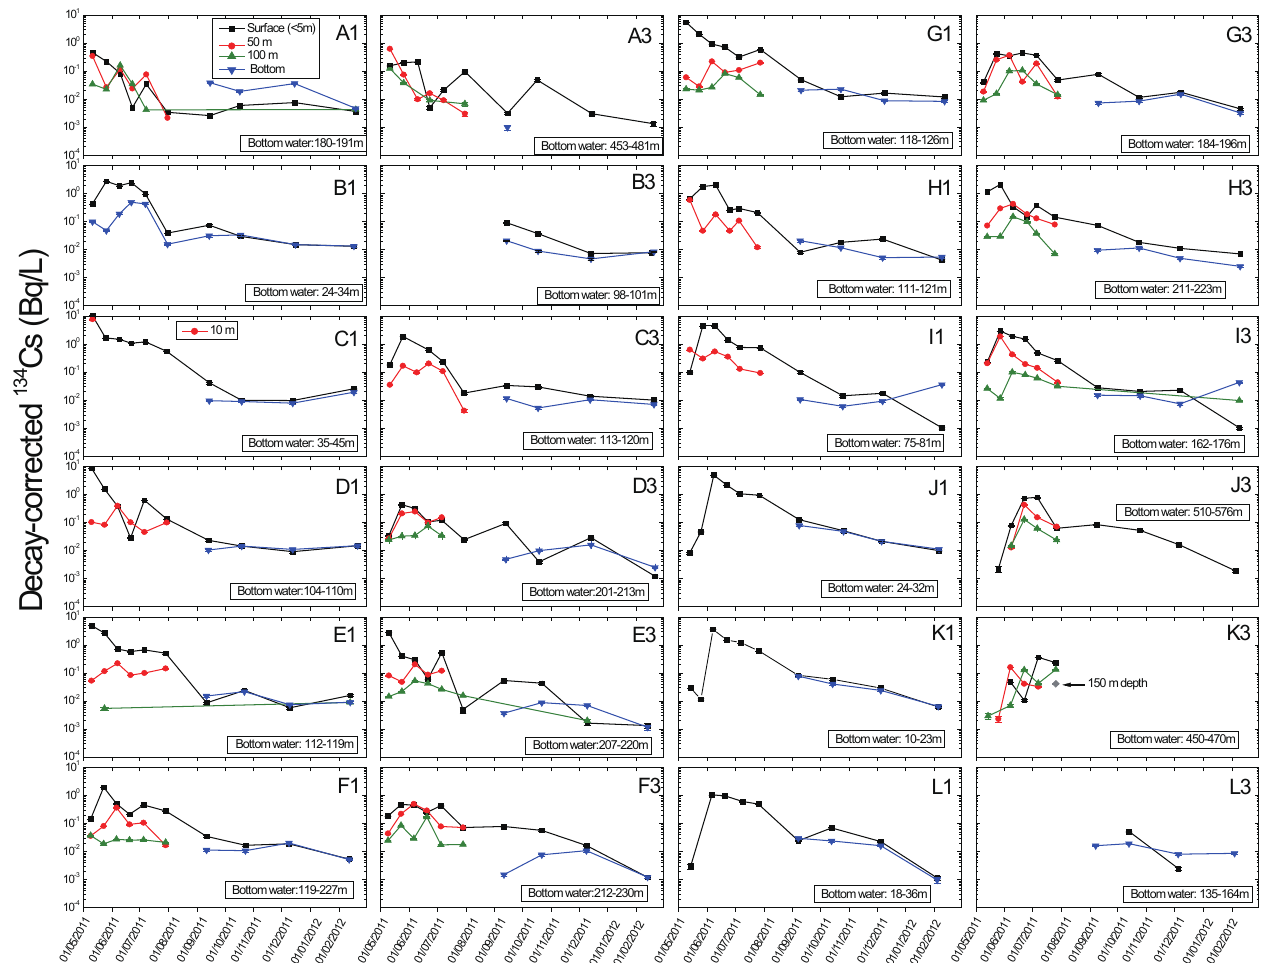
Fig. 5. Temporal variation of 134 Cs activities in seawater at each sampling depth. Error bars are less than or equal to the size of the symbols. Activities of 134 Cs were decay-corrected to 26 March 2011. Activities of 134 Cs in bottom waters were not detected at any stations from 9–14 May to 26–31 July by direct measurement with a gamma-ray